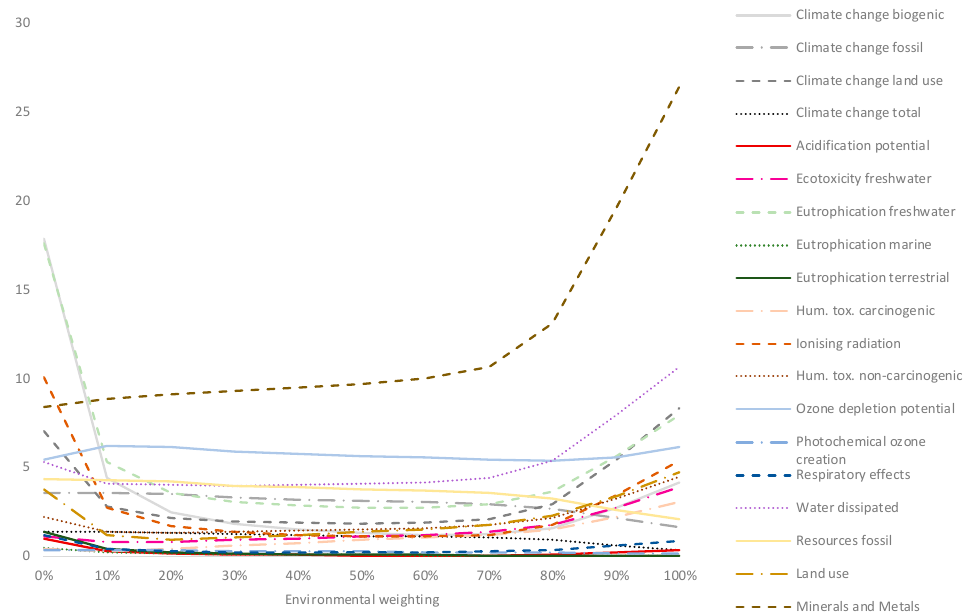
Figure 8. Normalised distance from minimum for environmental impact categories in dependence of the total environmental weighting compared to costs (logarithmic scale).